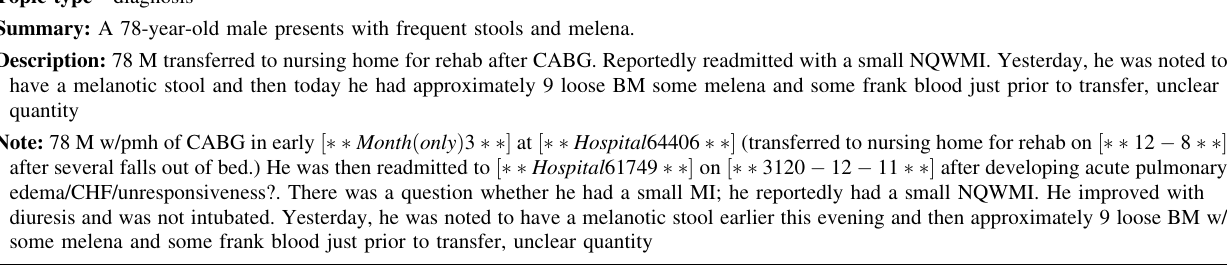
Table 1 Example of Summary , Description and Note fields Topic type - diagnosis